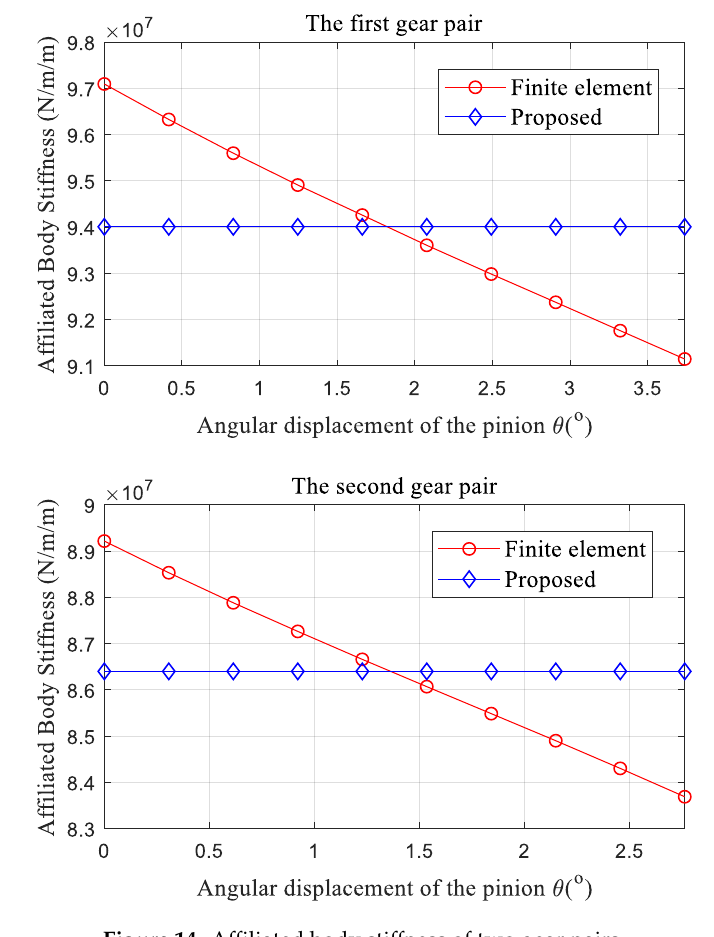
Figure 14. Affiliated body stiffness of two gear pairs. Figure 14. A ffi liated body sti ff ness of two gear